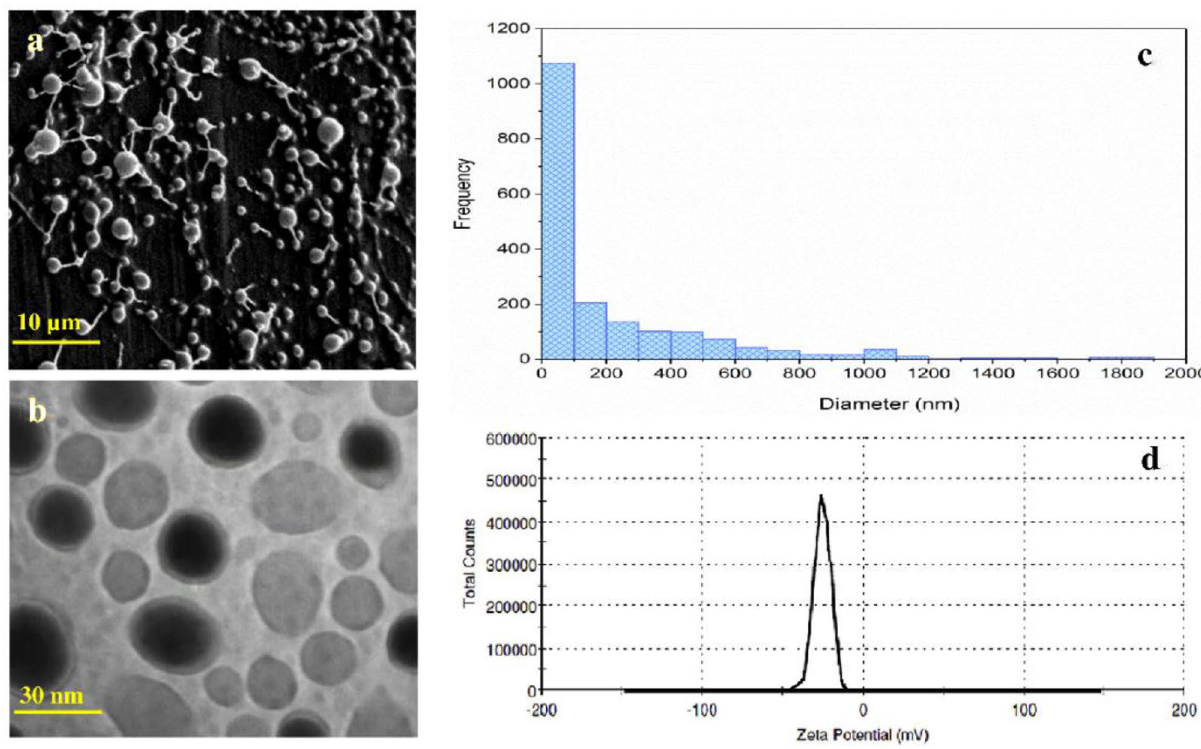
Figure 1. Characterization of synthesized Cur-NPhs. ( a ) Representative scanning electron micrograph (scale bar represents 10 μm). ( b ) Representative transmission electron micrograph (scale bar represents 30 nm). ( c ) Average particle size. ( d ) ζ-potential